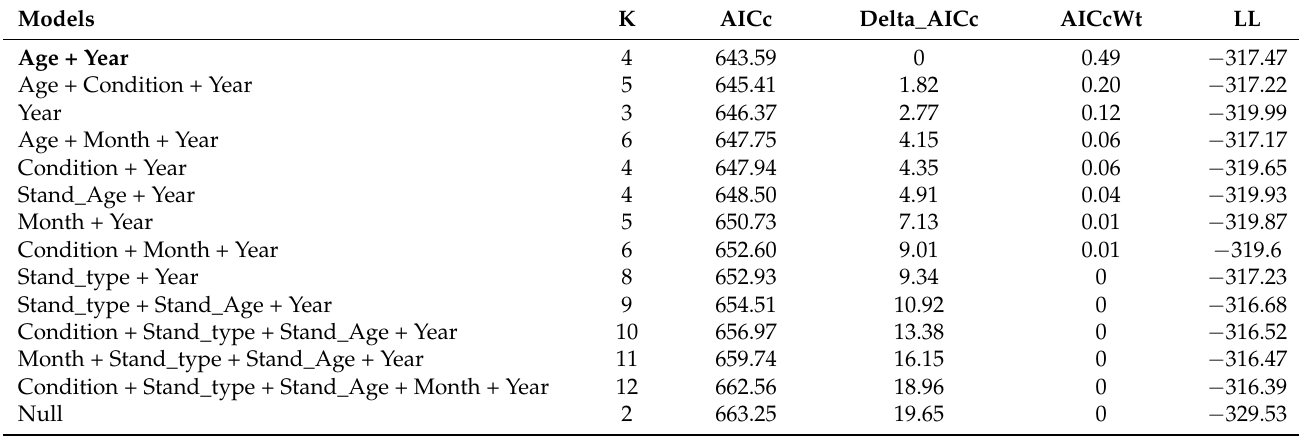
Table A4. Selection of linear models, based on Akaike criterion, explaining mushroom diversity consumed by all female white-tailed deer on Anticosti Island, Qu é bec, Canada. For each model, the number of estimated parameters (K), the second order Akaike criterion adjusted for small sample size (AICc), the delta AICc and weight (AICcWt) as well as the log-likelihood are given. Tested models include various combination of deer age (juvenile vs. adult), body condition index, forest stand type and age, as well as the month and year of